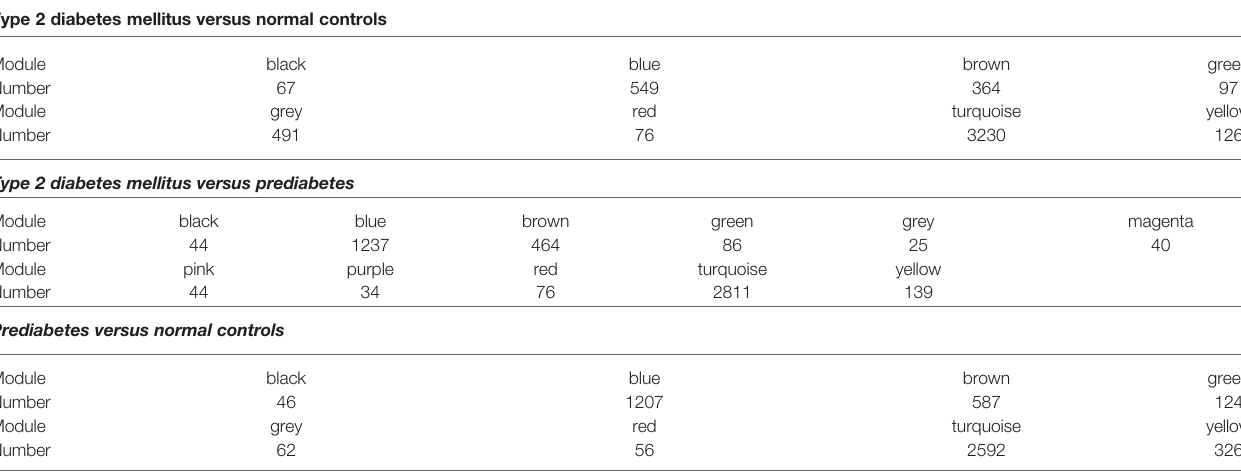
TABLE 3 | Number of lncRNAs contained in different modules. Type 2 diabetes mellitus versus normal